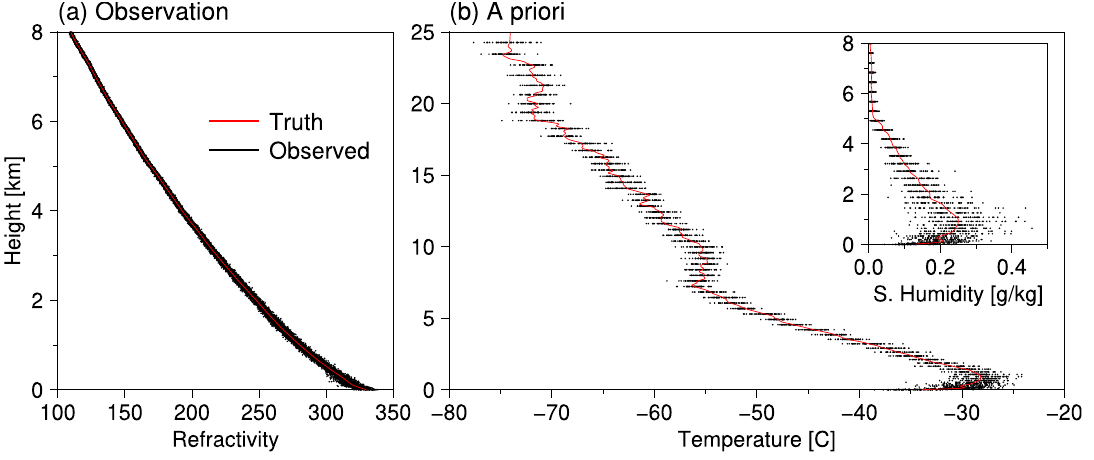
Figure 7. Synthetic 1D-Var input data for an Arctic case generated based on a GRUAN radiosonde observation and a collocated COSMIC profile. ( a ) The true atmospheric refractivity (red line) and assumed realizations of the observation (black dots). ( b ) Perfect, error-free a priori temperature and specific humidity (inset) profiles (red lines) and corresponding realizations (black dots).